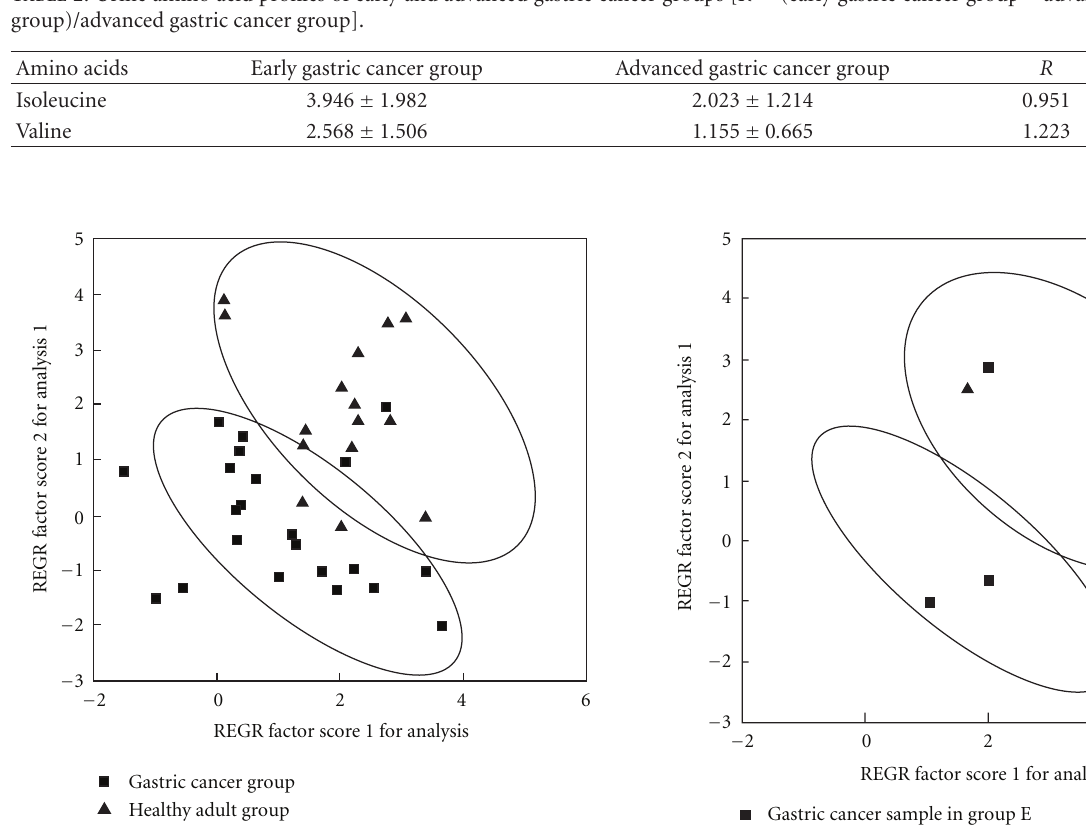
Figure 4: PCA scores plot of urine-free amino acids in healthy adult group and gastric cancer group (diagnosis model for gastric cancer).